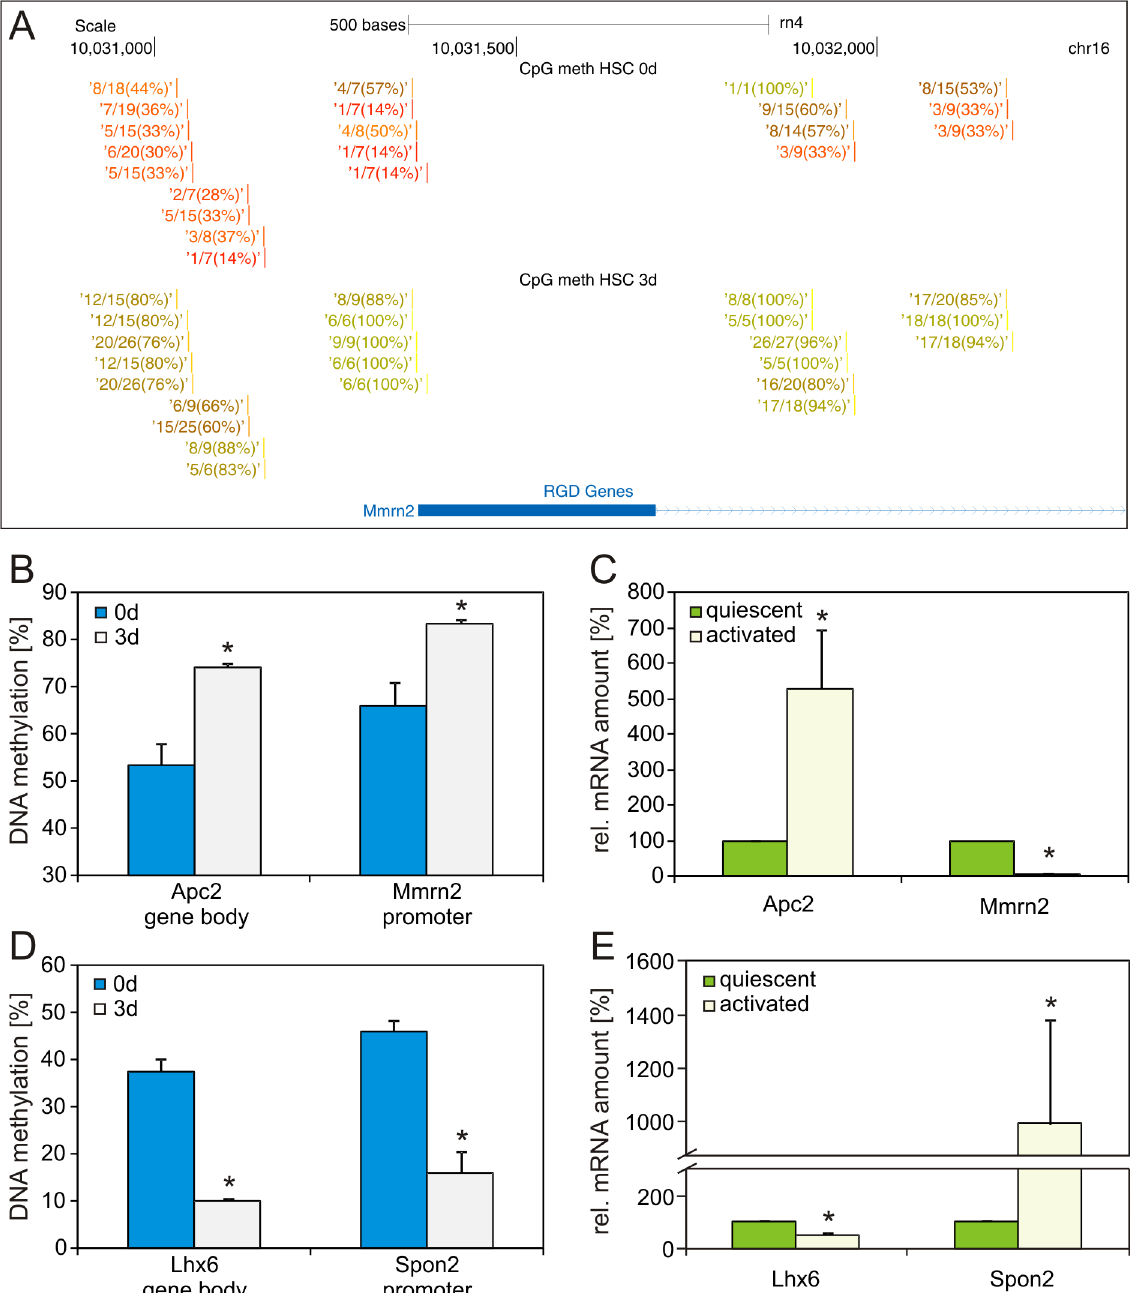
Fig 3. DNA methylation and expression analysis of genes identified by EpiQuest sequencing. (A) EpiQuest sequencing result of Mmrn2 promoter region displayed in UCSC genome browser. DNA methylation at individual CpG dinucleotides within the sequence are specified in percent. (B+D) DNA methylation analysis of two hyper- and hypomethylated genes by direct bisulfite sequencing (n = 3 independent experiments). The position of the analyzed region is indicated in the figure ( * p < 0.05). (C+E) Corresponding quantitative gene expression analysis to determine the effect of DNA methylation changes on the gene expression in quiescent (cultured overnight) and early activated (cultured for 3 days) HSC (n = 5 independent experiments).